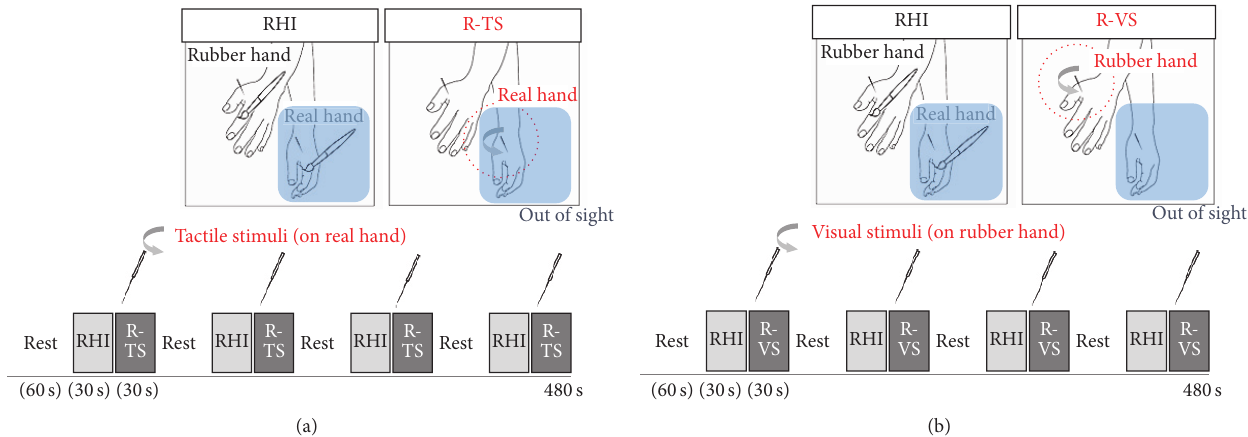
Figure 1: The two sessions involved the same degree of mechanical stimulation (needle rotation) in the real hand (reinstantiation by tactile stimuli or R-TS condition, (a)) and the rubber hand (reinstantiation by visual stimuli or R-VS condition, (b)). Each session included four blocks of brush strokes (30 s, at a frequency of 1Hz, synchronously on the same location on the rubber and real hand) to induce the rubber hand illusion (RHI) and four subsequent blocks of tactile or visual stimuli (30 s, at a frequency of 1Hz) immediately thereafter.